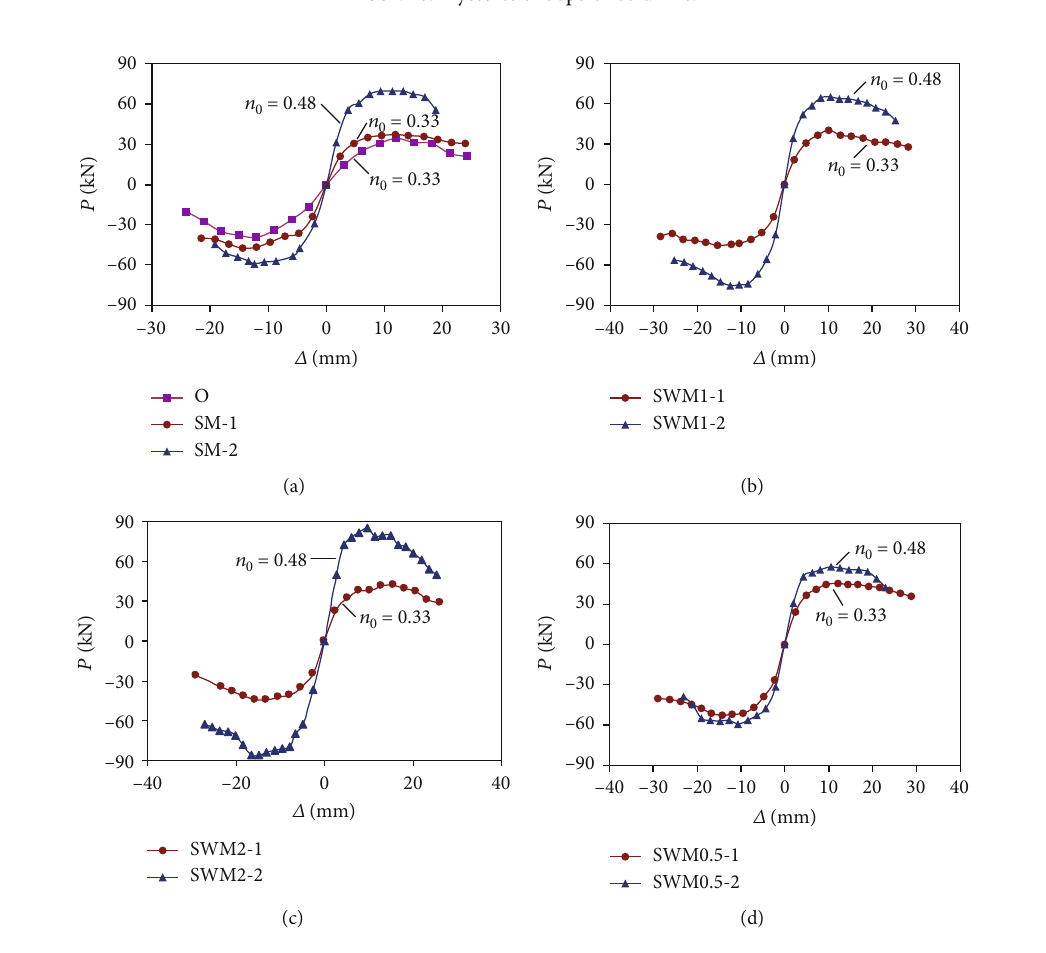
Figure 7: Skeleton curves of